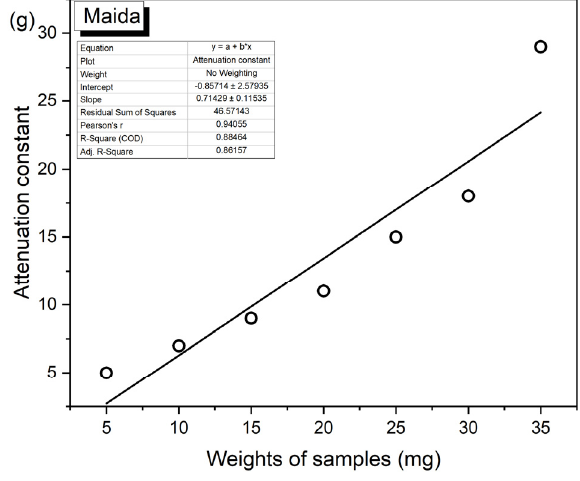
Figure 6. Attenuation constant for various cereals versus weight of samples ( a ) Punjab wheat ( b ) Samba wheat ( c ) Local wheat ( d ) Ration wheat ( e ) Aashirvadh TM ( f ) Pillabury TM ( g ) Maida.